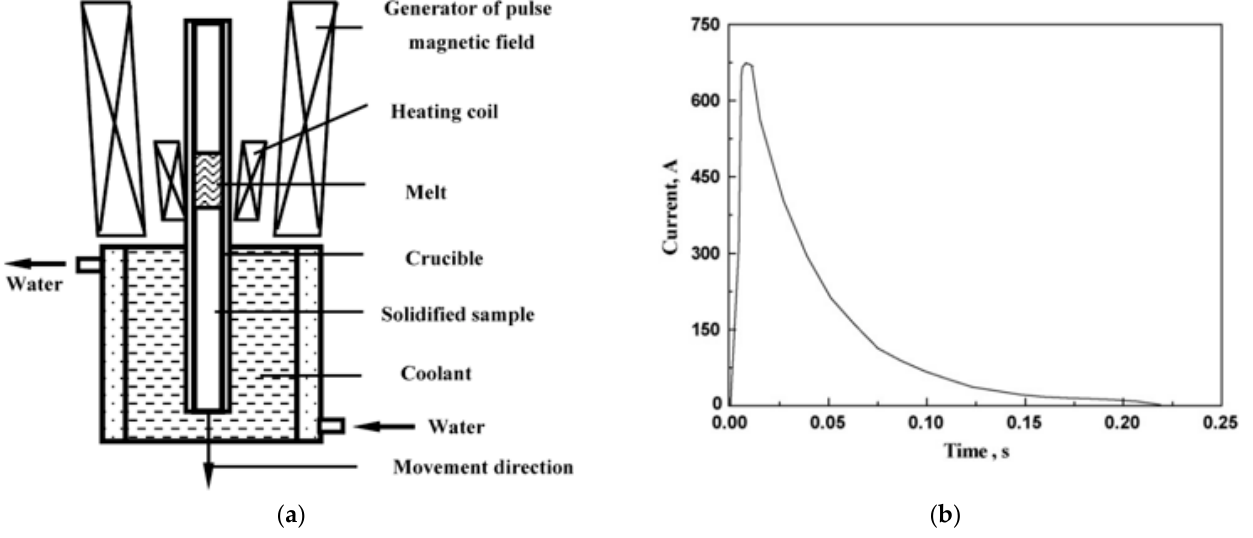
Figure 8. ( a ) S с heme of experimental setup; and ( b ) a discharge course of power supply of pulsed magnetic field [21]. magnetic field